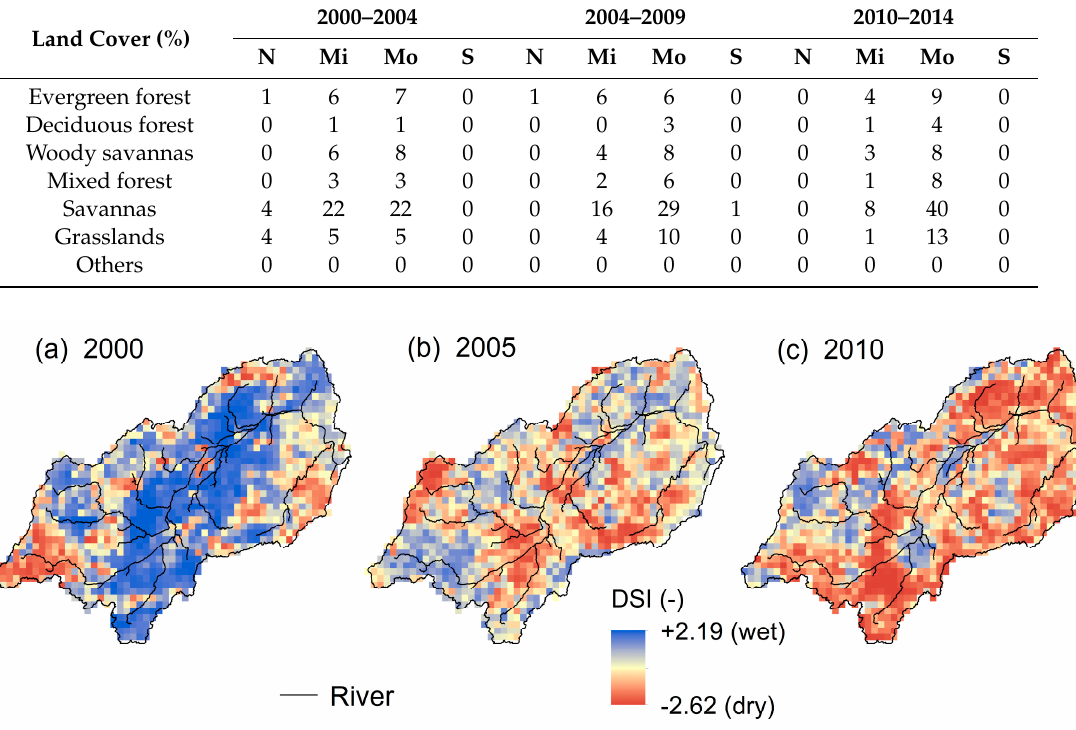
Figure 9. Annual terrestrial drought severity index (DSI) in the Kilombero River catchment for the years 2000 ( a ), 2005 ( b ), and 2010 ( c ) [22].